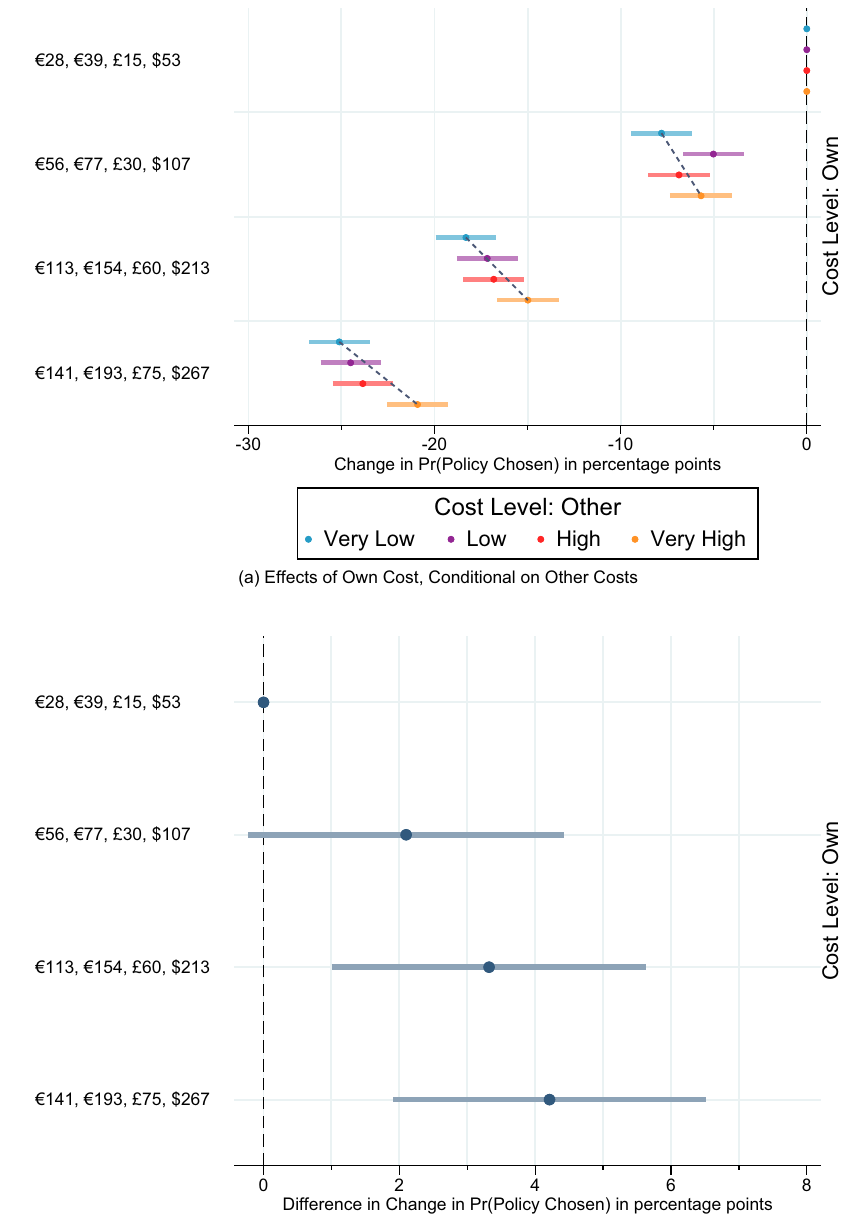
Fig. 4 | The causal effects of climate policy costs by other costs in France, Germany, UnitedKingdom,and theUnitedStates( N =129,280). a , b The fi gure reports coef fi cients from linear regressions of policy approval on randomly assignedclimatepolicyhouseholdcosts. a The fi gureshowstheeffectsofowncost conditional on other costs. b The fi gure reports the differences in the effects of